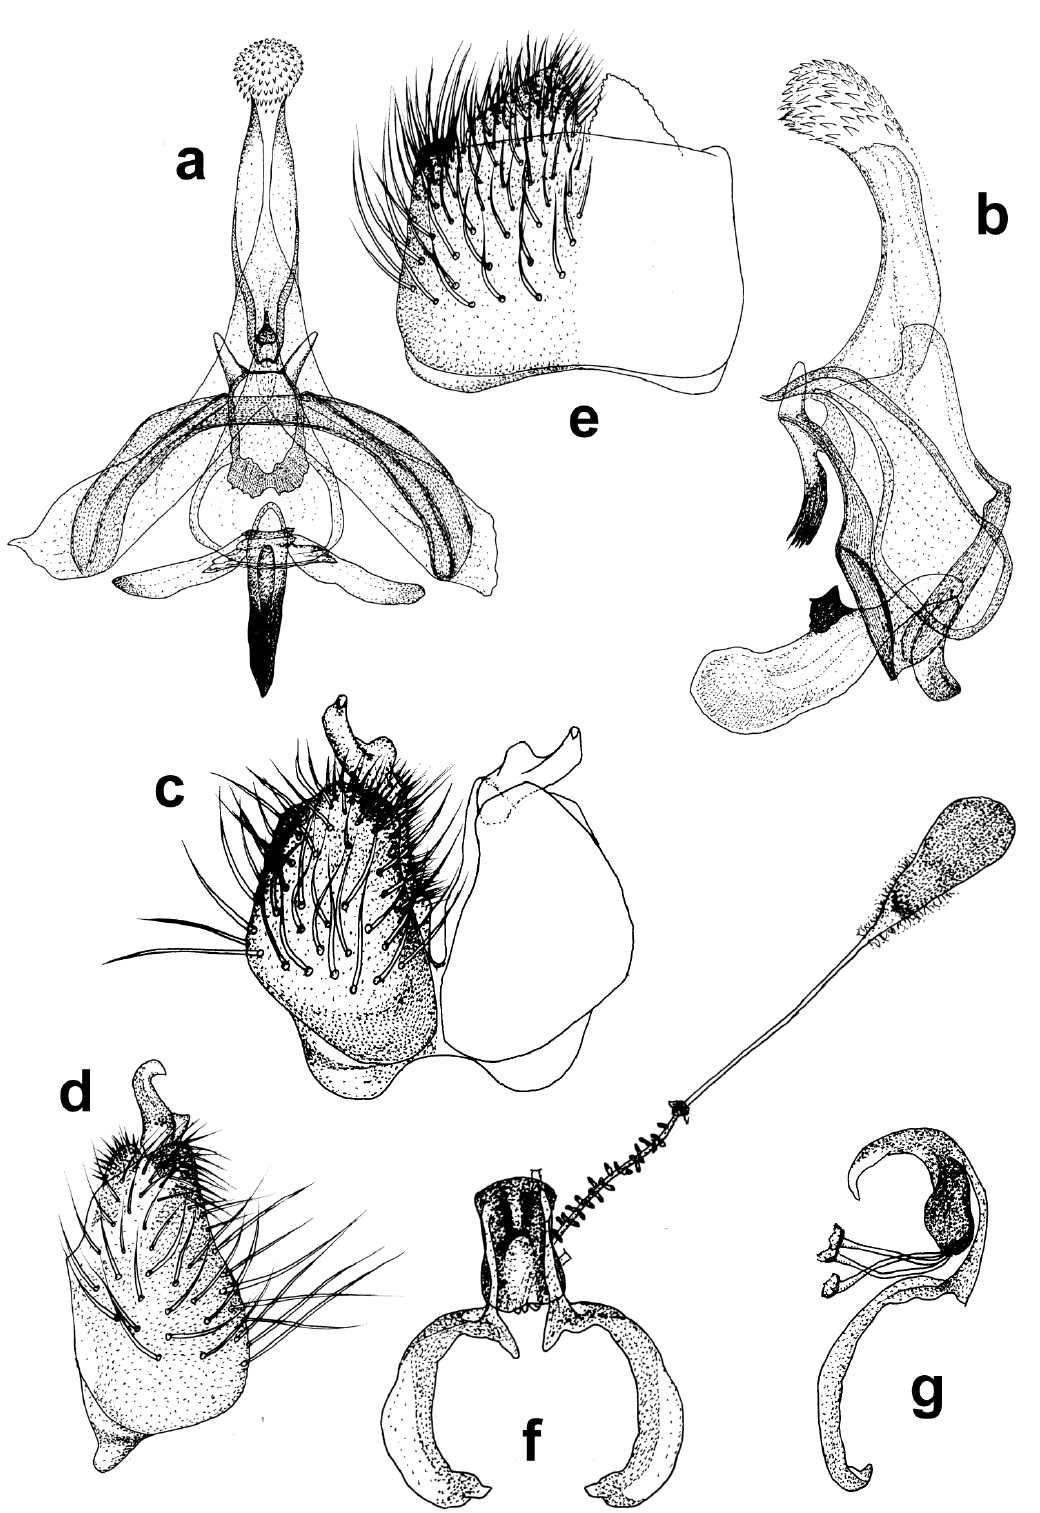
Fig. 39. Protypusia argentata gen. et sp. nov. a . Epiphallic complex ventral. b . Epiphallic complex lateral. c . Gonocoxite ventral. d . Gonocoxite lateral. e . Epandrium dorsal. f . Female genitalia ventral. g . Female genitalia